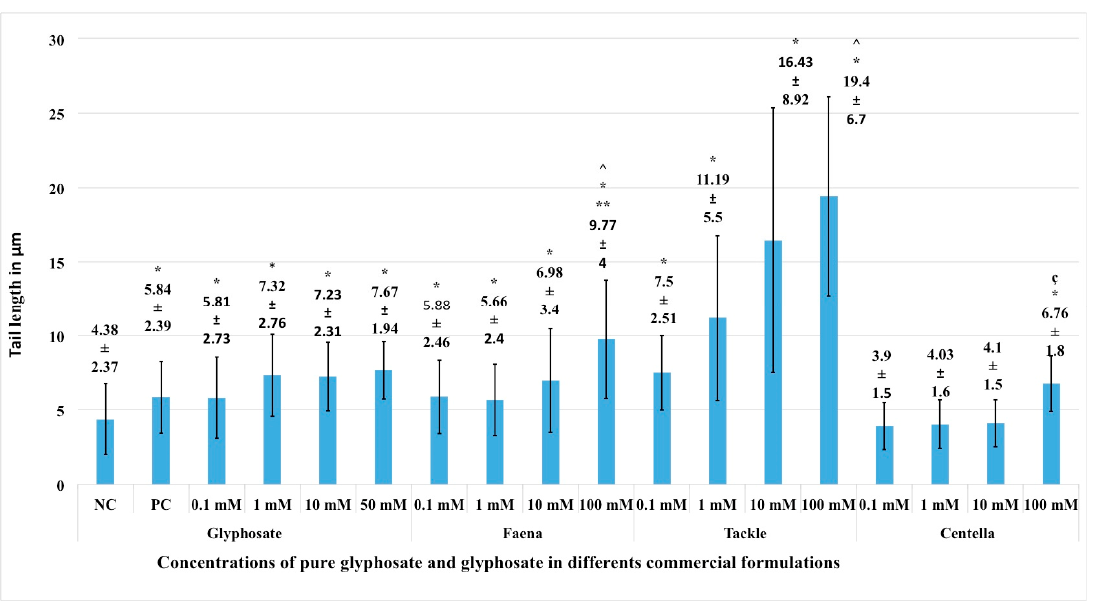
Figure 1. Tail length parameter. Genetic damage in blood cells exposed to different concentrations of G and in three glyphosate-based herbicides GBH. Note: G in each GBH was calculated according to informative paper, so the evaluated concentrations of G were similar to G. NC, negative control (phosphate buffer), PC, positive control (10 mM EMS). * Statistical difference with respect to NC ( p < 0.05). ^ Statistical difference of G 50 mM with respect to FAENA 100 mM and TACKLE 100 mM ( p < 0.05). ** Statistical difference between FAENA 100 mM and TACKLE 100 mM ( p < 0.05). ç Sta- tistical difference of CENTELLA 100 mM with respect to FAENA 100 mM and TACKLE 100 mM ( p < 0.05).